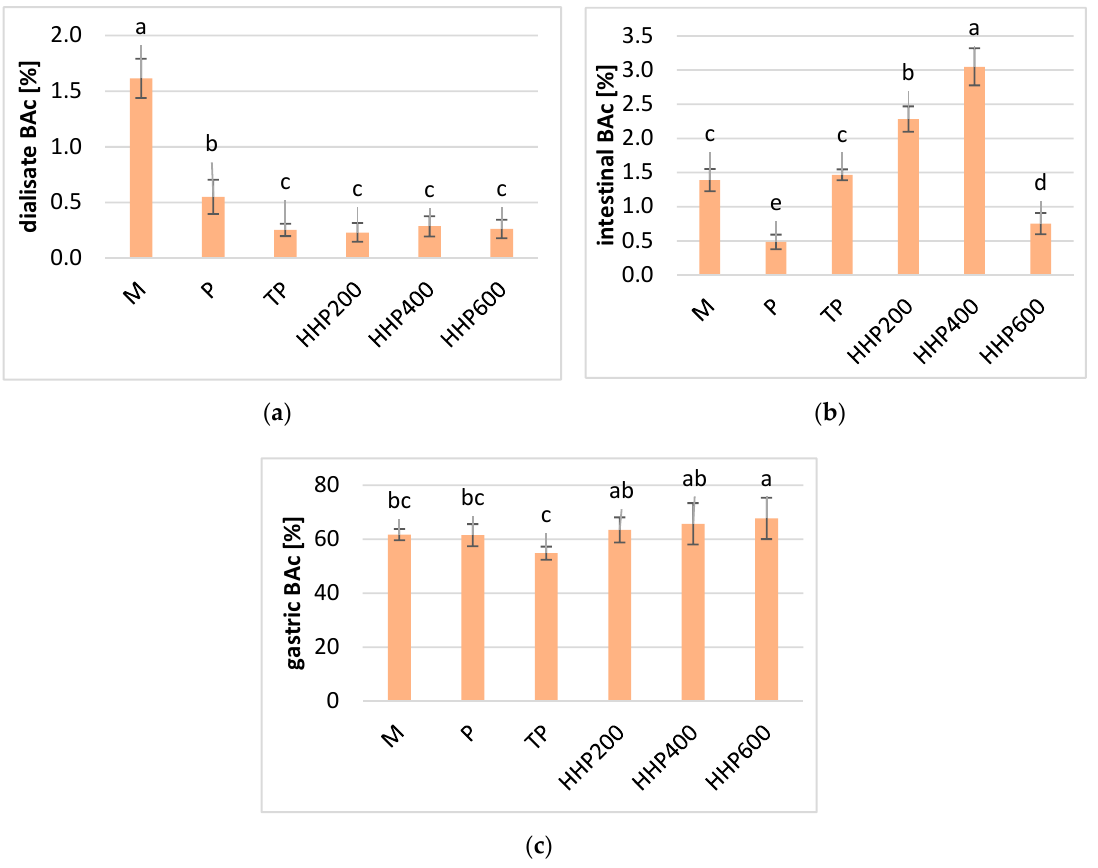
Figure 1. Relative bioaccessibility of total vitamin C in blackcurrants after different processing: M–crushed in a mortar; P–untreated puree; TP–thermal pasteurized puree; HPP200–high pressured puree at 200 MPa; HPP400–high pressured puree at 400 MPa; HPP600–high pressured puree at 600 MPa; ( a ) in the dialysate stage; ( b ) in the intestinal stage; ( c ) in the gastric stage; small letters a–e indicate statically significant di ff erences in the mean values between samples at a confidence level of α = 0.05